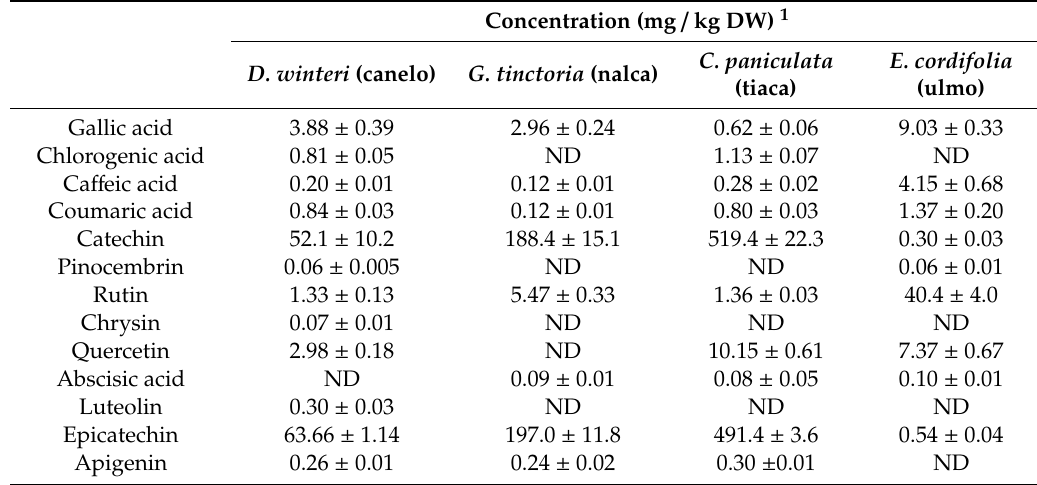
Table 2. Phenolic composition in plant extracts by UHPLC-MS /